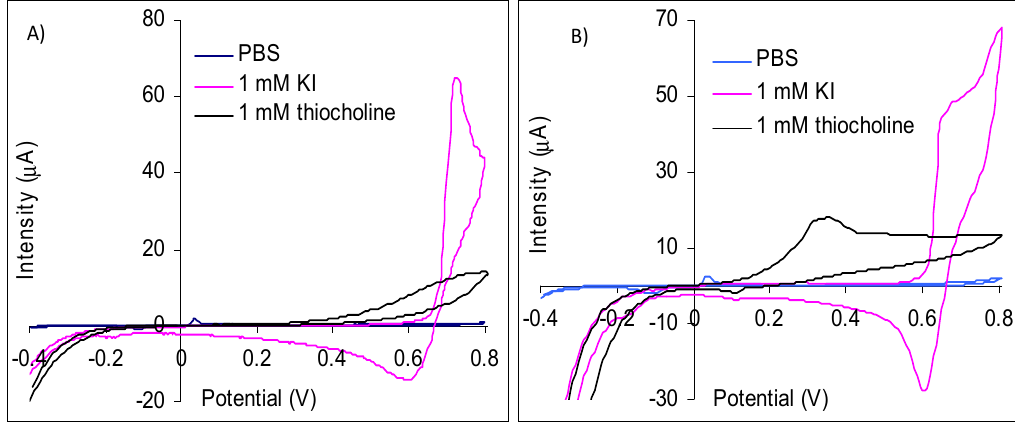
Figure 1. The cyclic voltammograms obtained in PBS, iodide and thiocholine solutions using: ( A ) carbon screen-printed electrode. ( B ) CNT screen-printed